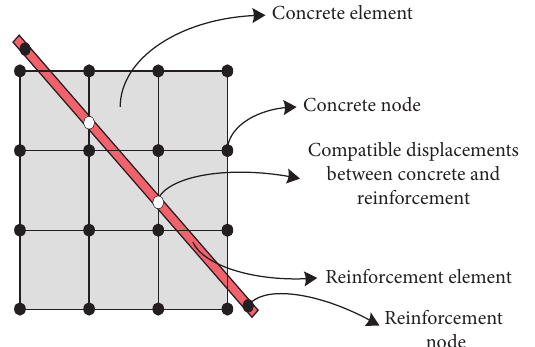
Figure 2: Reinforcement is placed embedded in concrete solid (embedded model).